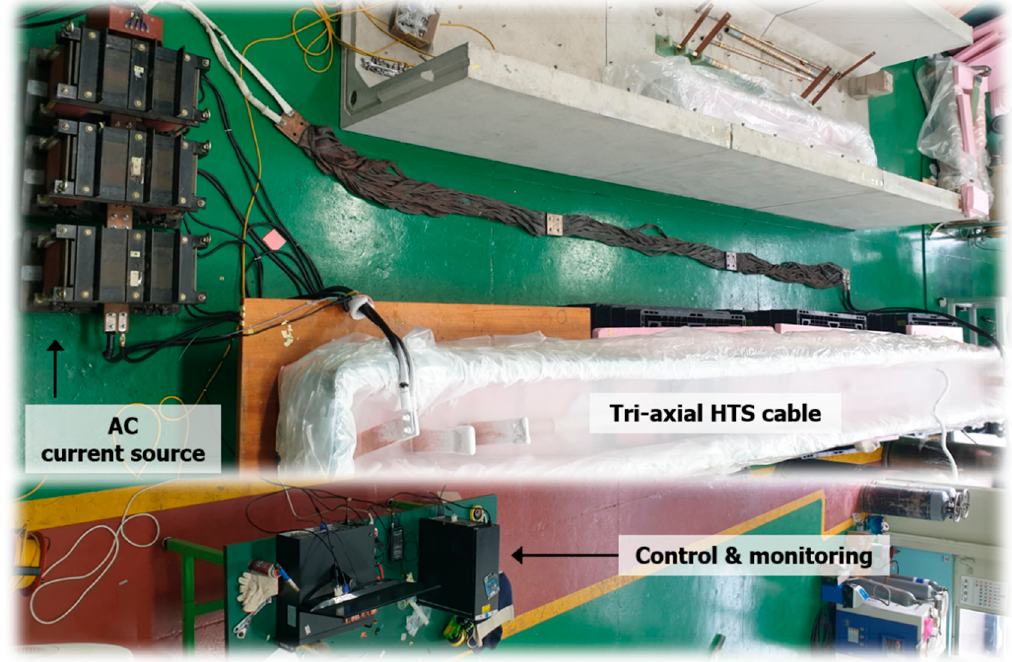
Figure 14. Real configuration of AC loss measurement for the 6-m-long tri-axial HTS power cable.